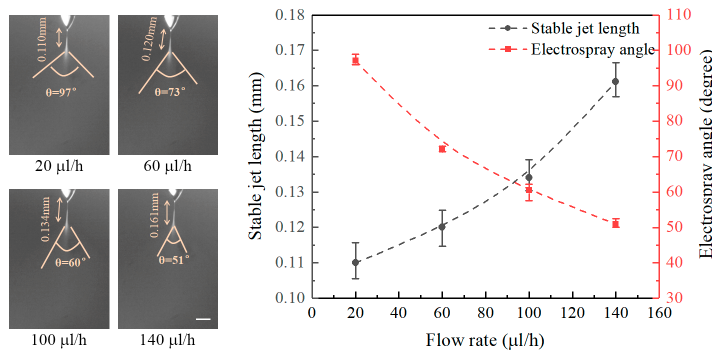
Figure 3. Effect of flow rate on the stable jet length and electrospray angle. The nozzle-to-substrate distance is 20 mm and the applied voltage is 6 kV. Scale bar: 0.1 mm.